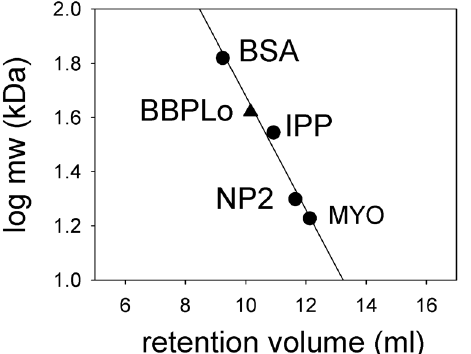
Figure 3. Molecular weight determination of recombinant BBPLo by gel filtration chromatography on Superdex 75. Standards: MYO (myoglobin), 16.9 kDa; NP2 (nitrophorin 2), 19.9 kDa; IPP ( R. prolixus inositol polyphosphate 5-phosphatase), 35.0 kDa; BSA (bovine serum albumin), 66 kDa. The position of the BBPLo point is based on a calculated molecular weight of 42 kDa for a dimer of the recombinant protein.